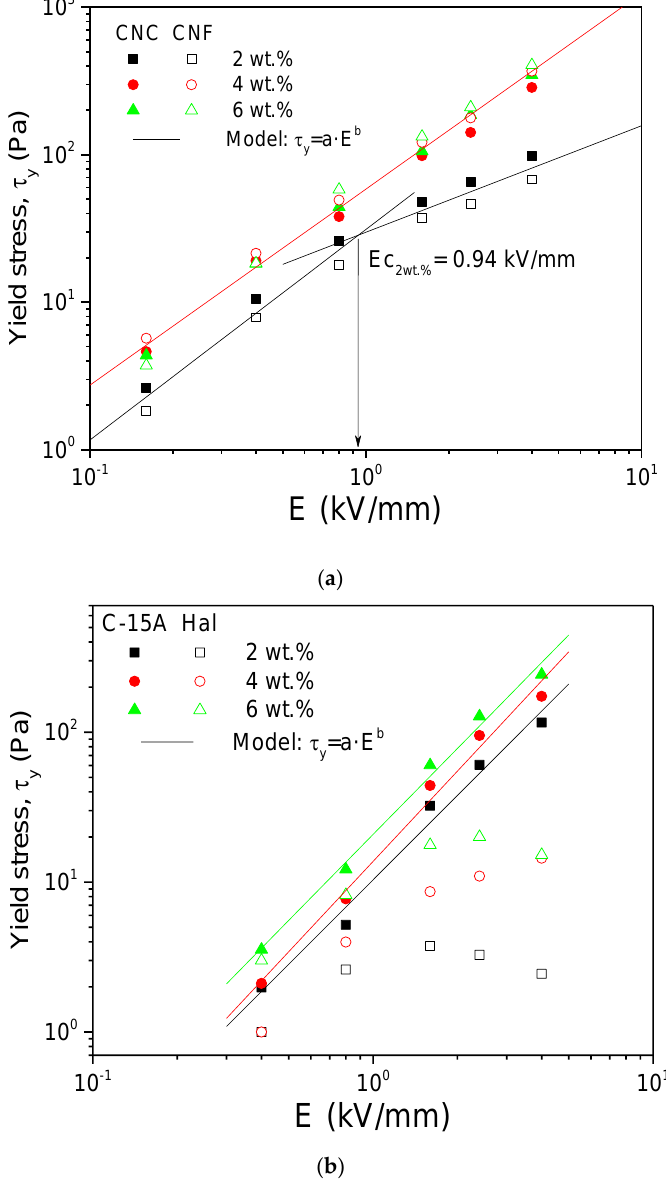
Figure 7. Evolution of the yield stress with the electric field strength for ( a ) the nanocelluloses and ( b ) the nanoclays dispersions in castor oil.